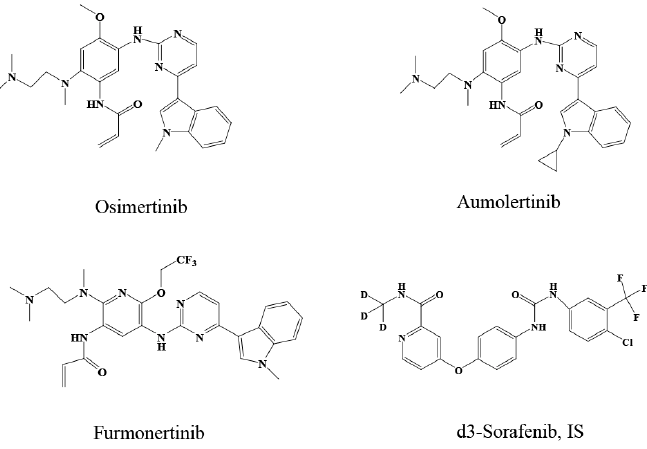
Figure 1. Chemical structures of osimertinib, aumolertinib furmonertinib, and IS.